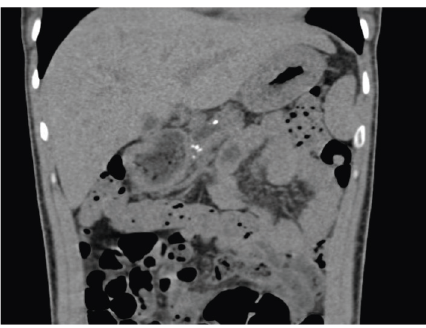
Figure 2: Coronal noncontrast CT through the upper abdomen shows calcifications along the body of the pancreas and mild di- latation of the pancreatic duct measuring up to